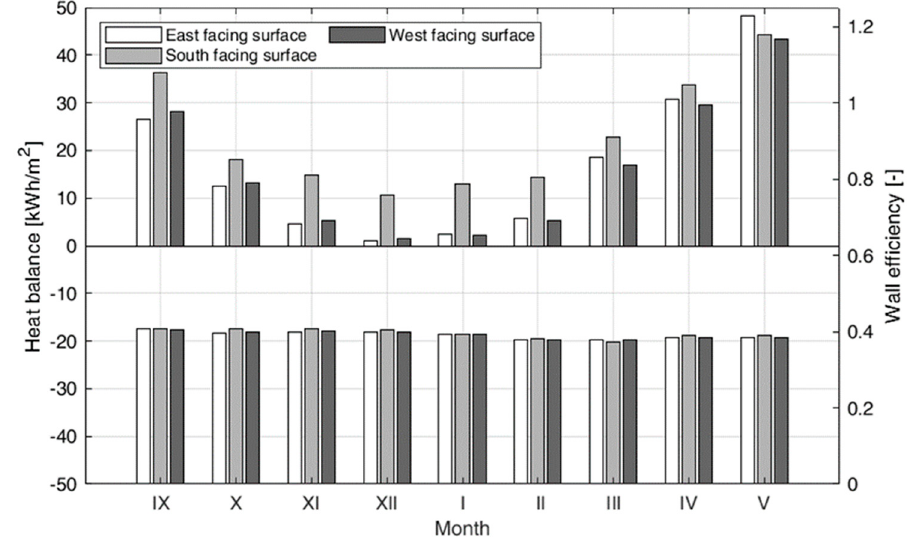
Figure 14. Comparison of monthly thermal balances (top) and thermal e ffi ciency (bottom) of the SW-TI with the insulation thickness of 108 mm in the case of different orientations (location in Racibórz).